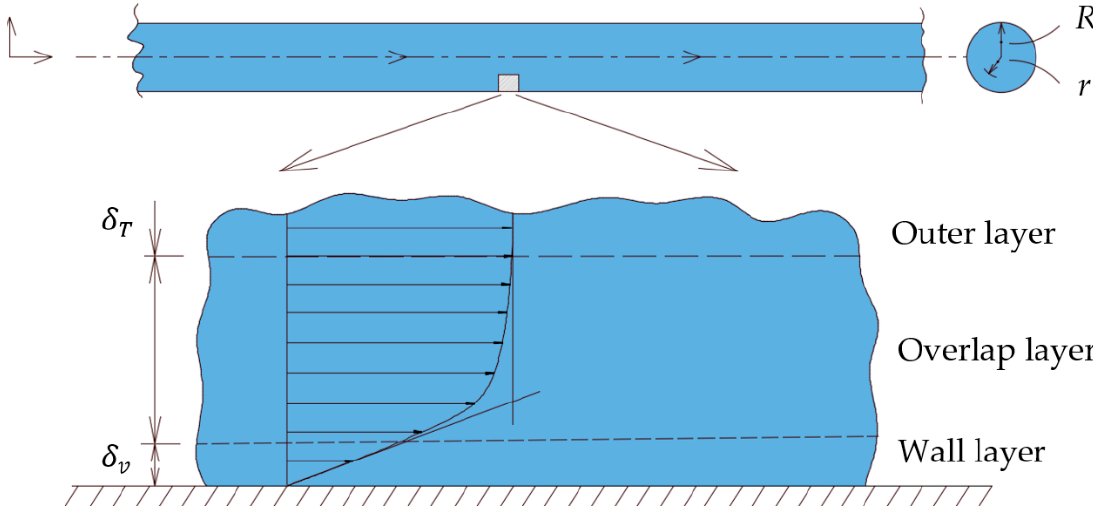
Figure 3. Schematic of velocity profile in the near wall region along with the three designated sublayers; namely, the wall layer, the overlap layer and the outer layer.